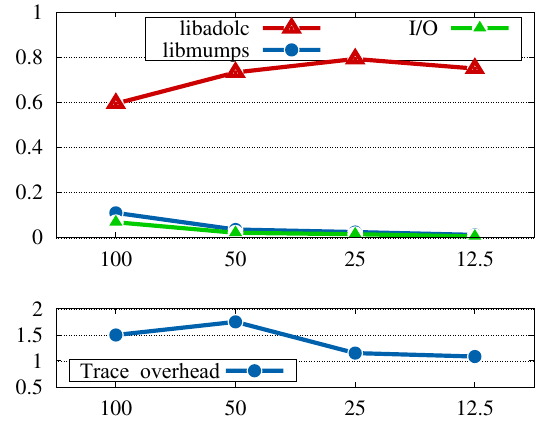
Figure 6. Test problem setup with the parallel MUMPS solver; plots over max mesh distance show approximate runtime portions of the model execution with adjoint computation (upper frame) and over- head factors for the trace creation and interpretation (lower